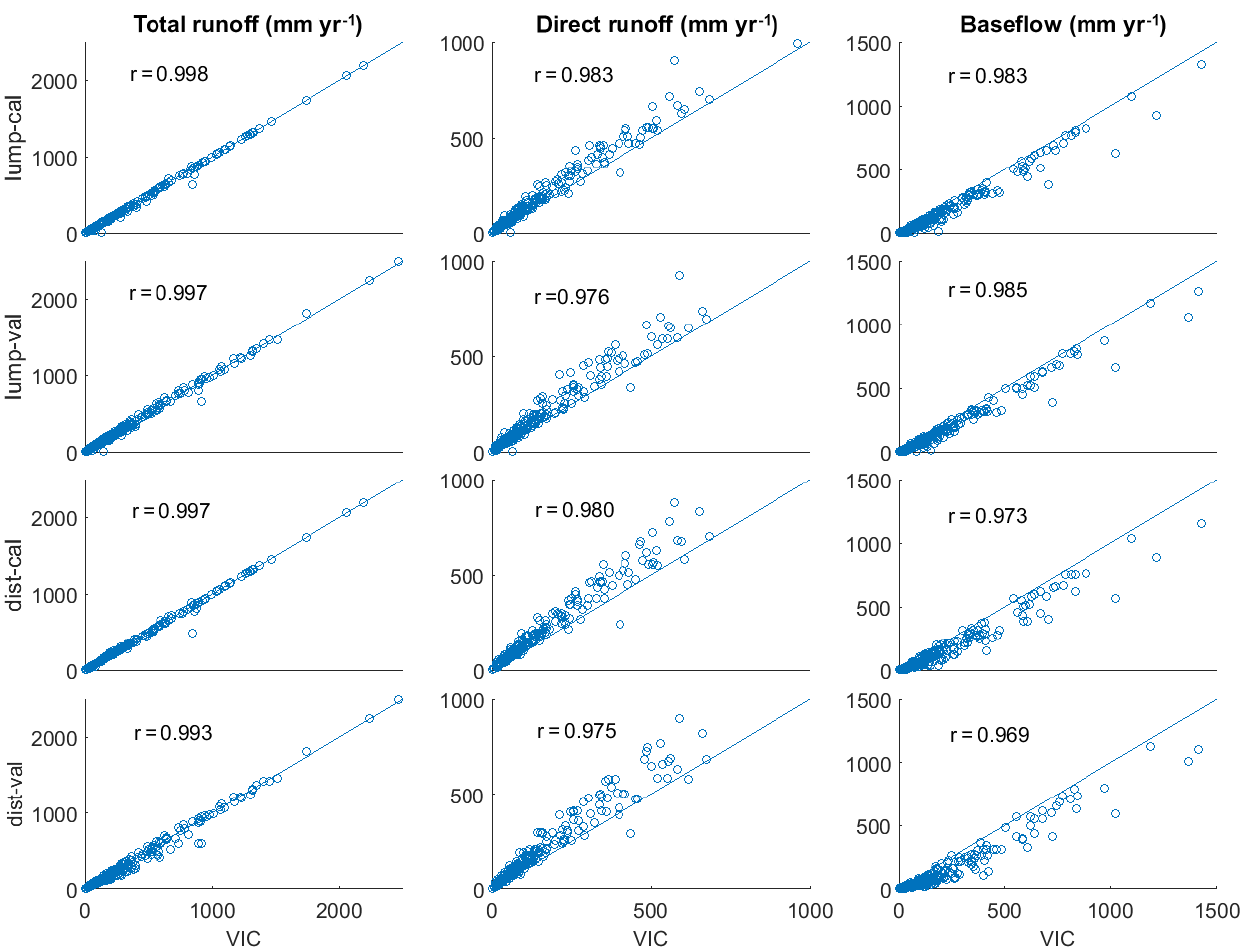
Figure 3. Comparison of basin-specific long-term annual total runoff, direct runoff, and baseflow estimates from both the lumped and distributed abcd model schemes against VIC products, across the global 235 basins and for the calibration period of 1971–1990 and validation period of 1991–2010. The labels are denoted as a combination of model scheme and period, where lump and dist stand for lumped and distributed model scheme and cal and val represent the calibration and validation period, respectively. These denotations remain the same for all figures in this work. Note that the basin-level VIC baseflow is derived by multiplying the gridded VIC long-term annual total runoff and the mean of the four gridded baseflow index products from Beck et al. (2013) and then aggregating from grid level to basin level. The basin-level VIC direct runoff is then calculated by subtracting baseflow from the total